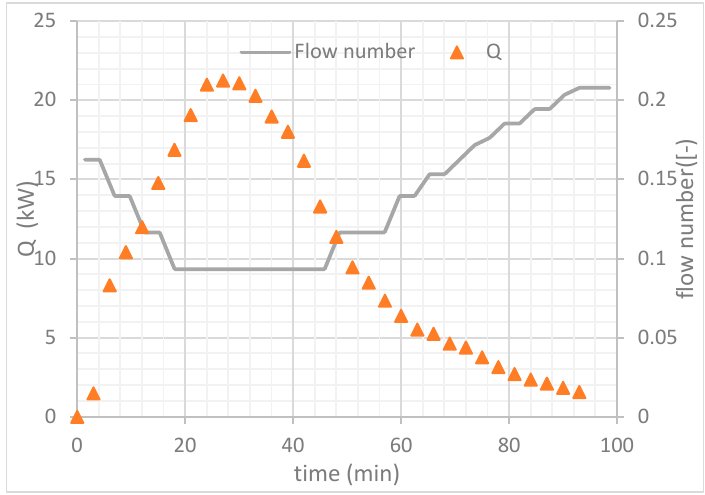
Figure 4. Development of Q at different flow rates over the whole period.